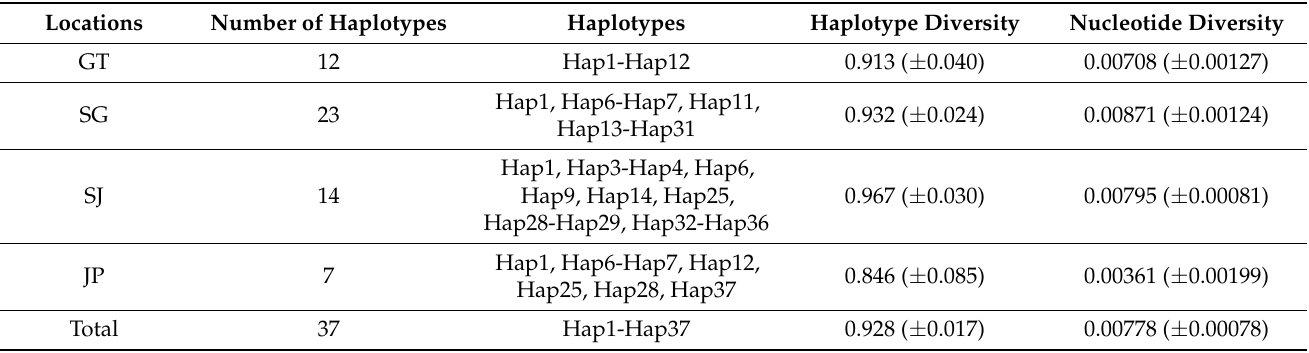
Table 3. Genetic diversity of Schizothorax kozlovi at different locations of the upper Yangtze River based on the concatenated Cyt b and COI genes sequences.